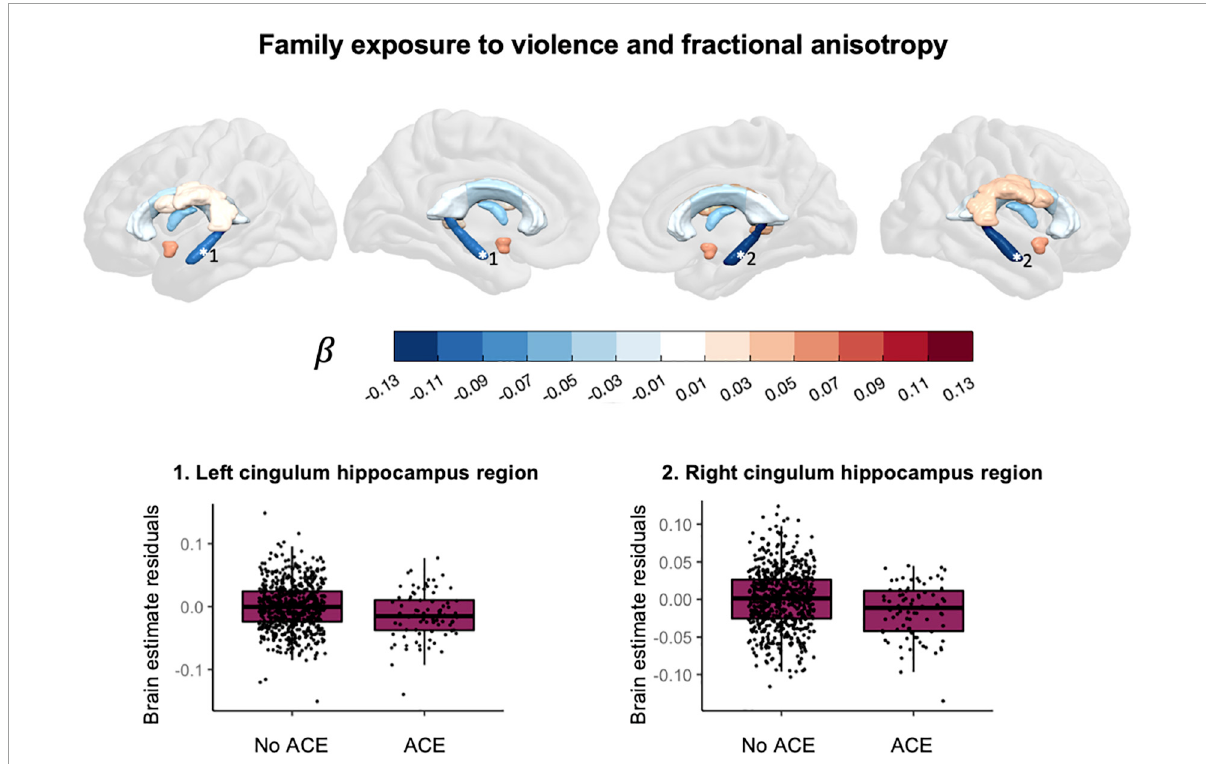
FIGURE5 Associations between exposure to violence and fractional anisotropy.